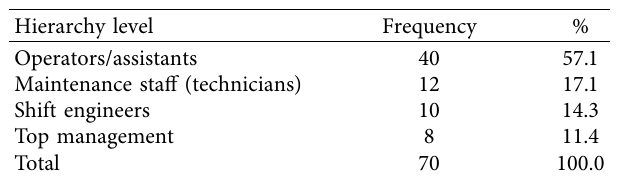
Table 3: Hierarchy